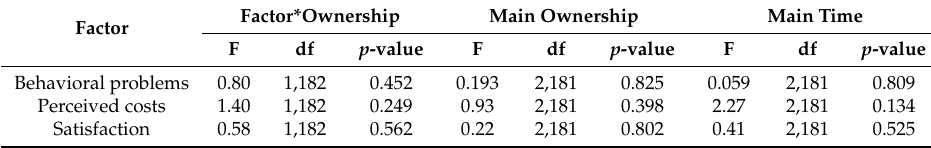
Table 3. General Linear modeling of changes in the outcome measures over time (T1 and T2).